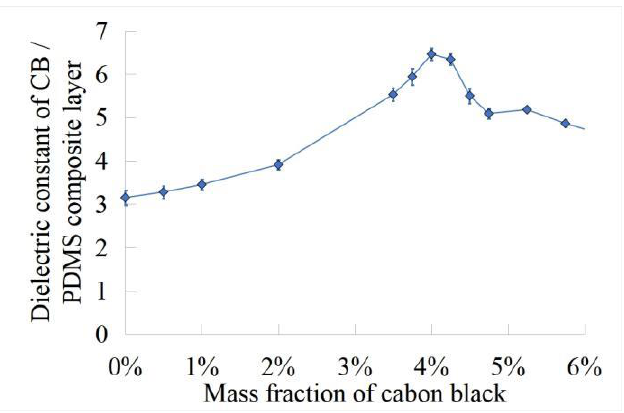
Figure 7. Dielectric constant of carbon black/PDMS composites with different mass fractions.